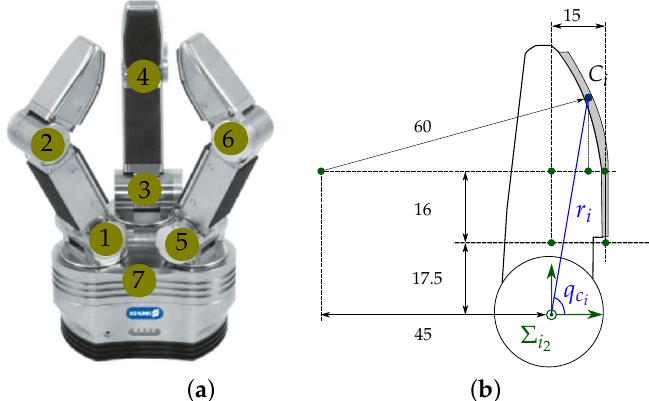
Figure 9. ( a ) Schunk Dexterous Hand (SDH2) with joints labels; ( b ) lateral view of the fingertip with the sensor pad (distances are in millimeters).